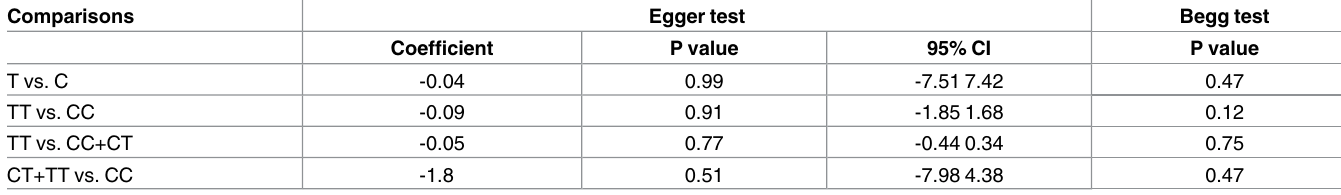
Table 3. Publication bias test for the MTHFR C677T polymorphism.